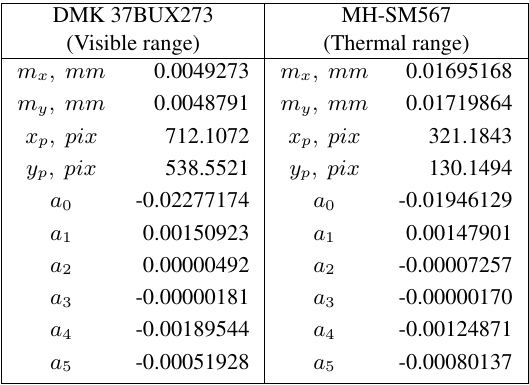
Table 4. Results of cameras